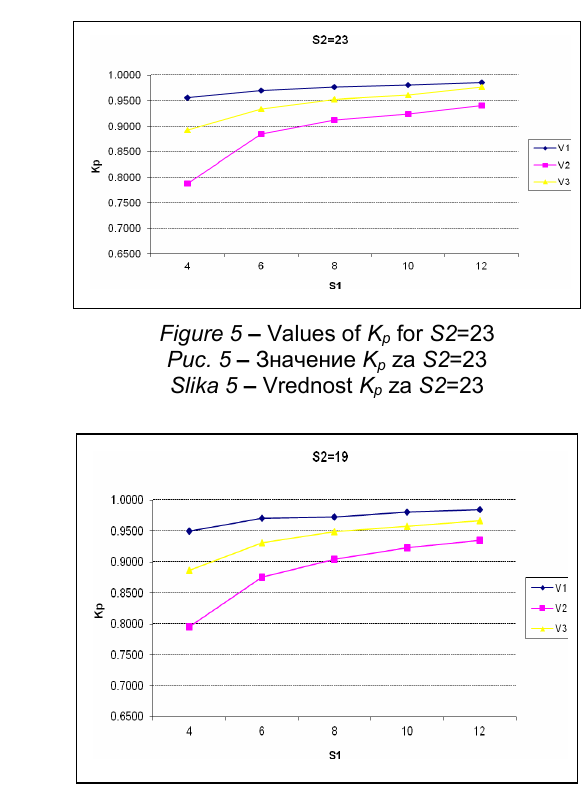
Figure 6 – Values of K p for S2 =19 Рис . 6 – Значение K p za S2 =19